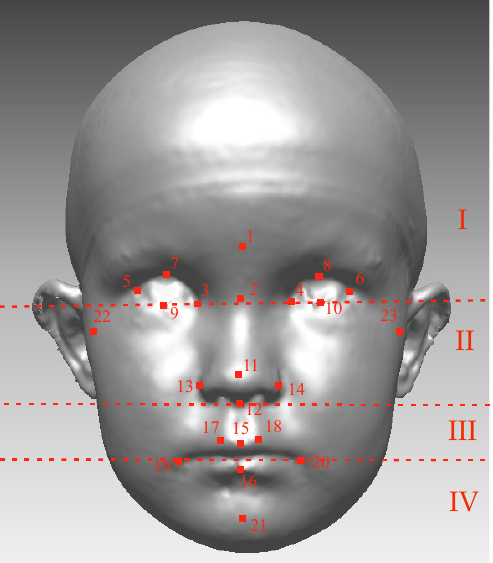
Figure 2. The Farcas soft-tissue landmarks: 1 Glabella (g); 2 Nasion (n); 3, 4 Endocanthion (en); 5, 6 Exocanthion (ex); 7, 8 Pulpabrale superius (ps); 9, 10 Pulpabrale inferius (pi); 11 Pronasale (prn); 12 Subnasale (sn); 13, 14 Alare (al); 15 Labiale superius (ls); 16 Labiale inferius (li); 17, 18 Christa philtra (cph); 19, 20 Cheilion (ch); 21 Pogonion (pg); and 22, 23 Tragion (Tr). Facial images were divided into four areas according to dashed lines: ( I ) the upper face (above the endocanthion line); ( II ) the upper mid-face (between the endocanthion line and the subnasal); ( III ) the lower mid-face (between the subnasal and the cheilion line); ( IV ) the lower face (under the cheilion line).